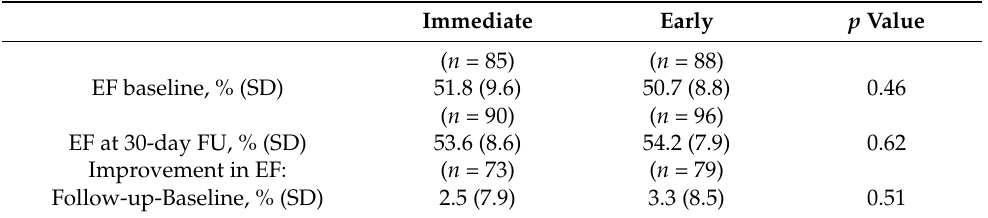
Table 2. Comparison of Left Ventricular Ejection Fraction for